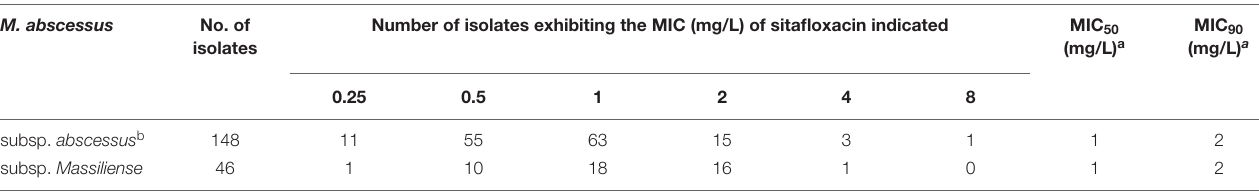
TABLE 2 | MIC distribution of sitafloxacin for 194 clinical, M. abscessus isolates.